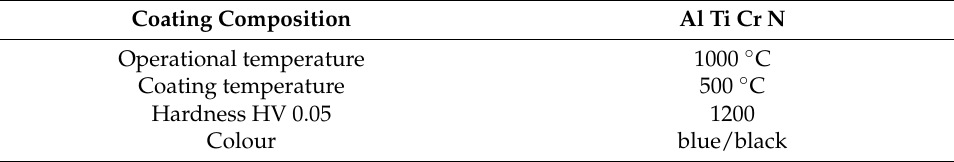
Figure 3. Saw blades with KTRN I coating (HSS_K_I, SK_K_I) . Table 3. Technical parameters of KTRN I coating, AlTiCrN (www.ionbond.com, 10/10/2018) . Table 3. Technical parameters of KTRN I coating, AlTiCrN (www.ionbond.com, accessed on 10 October